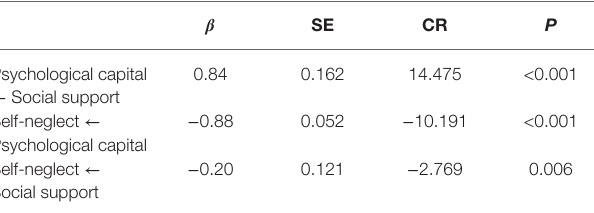
TABLE 4 | The path coefficients of the mediation model.